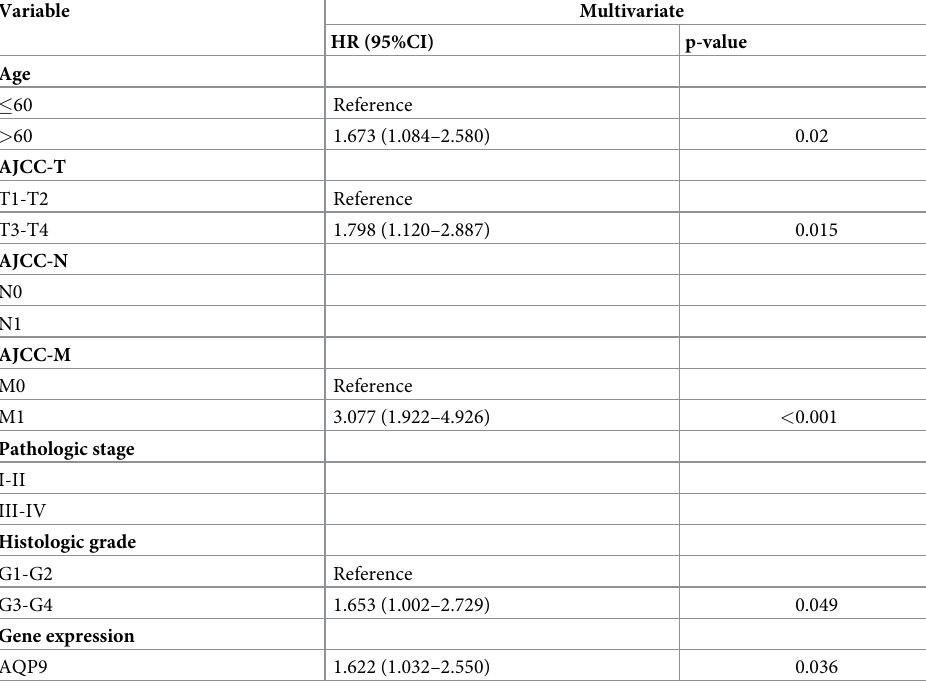
Table 8. Multivariate analysis of overall survival in 526 ccRCC